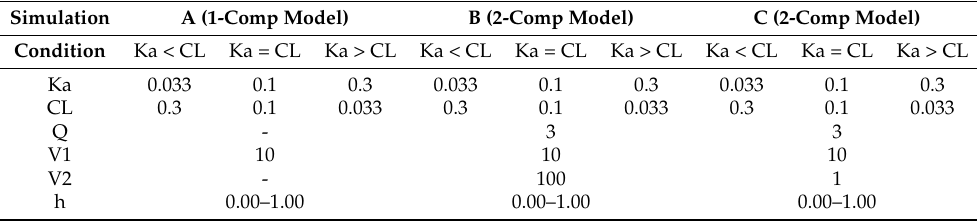
Table 1. Summary of the conditions and parameters used in the simulation